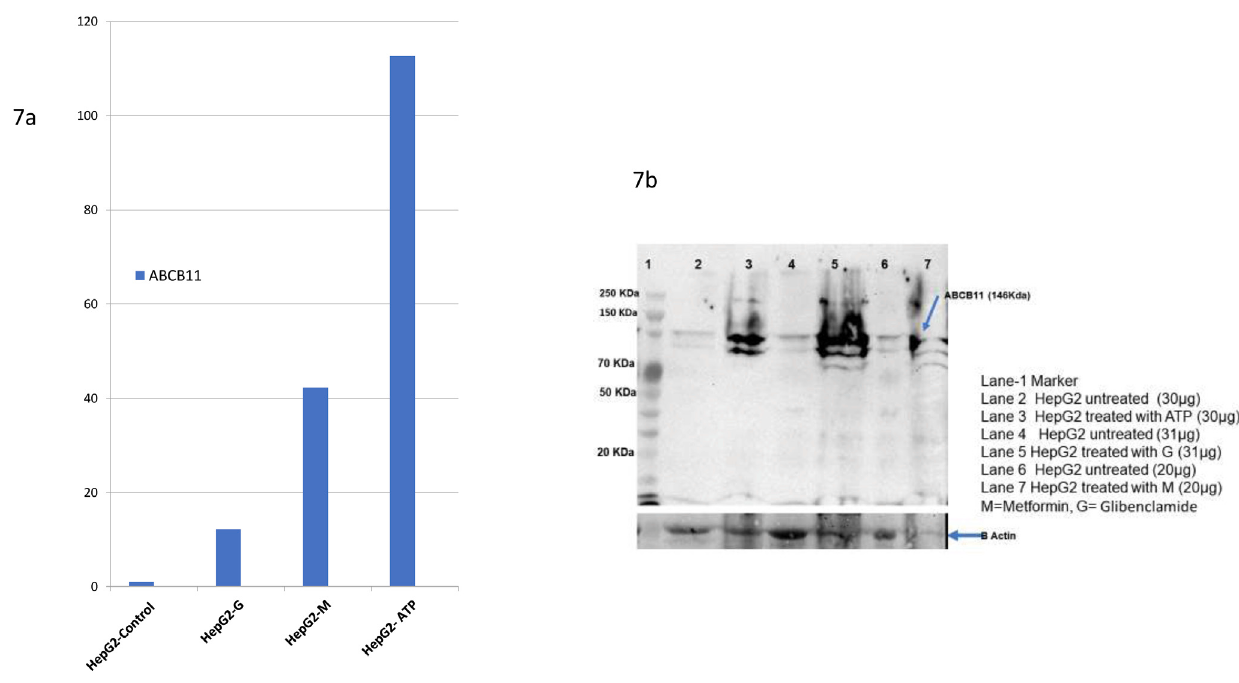
Figure 7. Three drugs, two of which were bioinformatically predicted (Glibenclamide, ATP) and one (Metformin) based on evidence from literature. All the three compounds upregulated ABCB11 expression based on Real Time PCR data. This was further confirmed by Western Blot against anti-human ABCB11 antibody as the primary antibody. The upper image in 7b shows the PVDF membrane probed with antibody against ABCB11 and the lower image shows the same membrane stripped and probed with antibody against beta- actin (loading